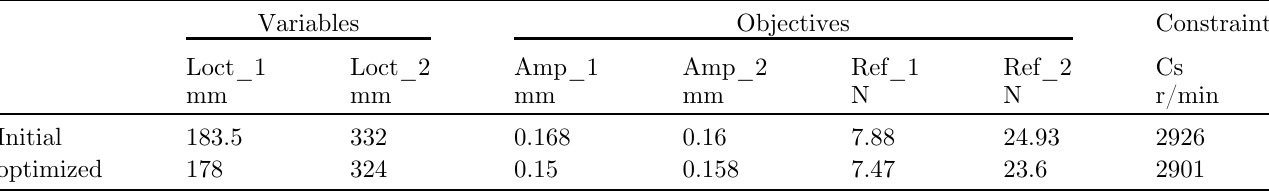
Table 1. The rotor optimization design result.